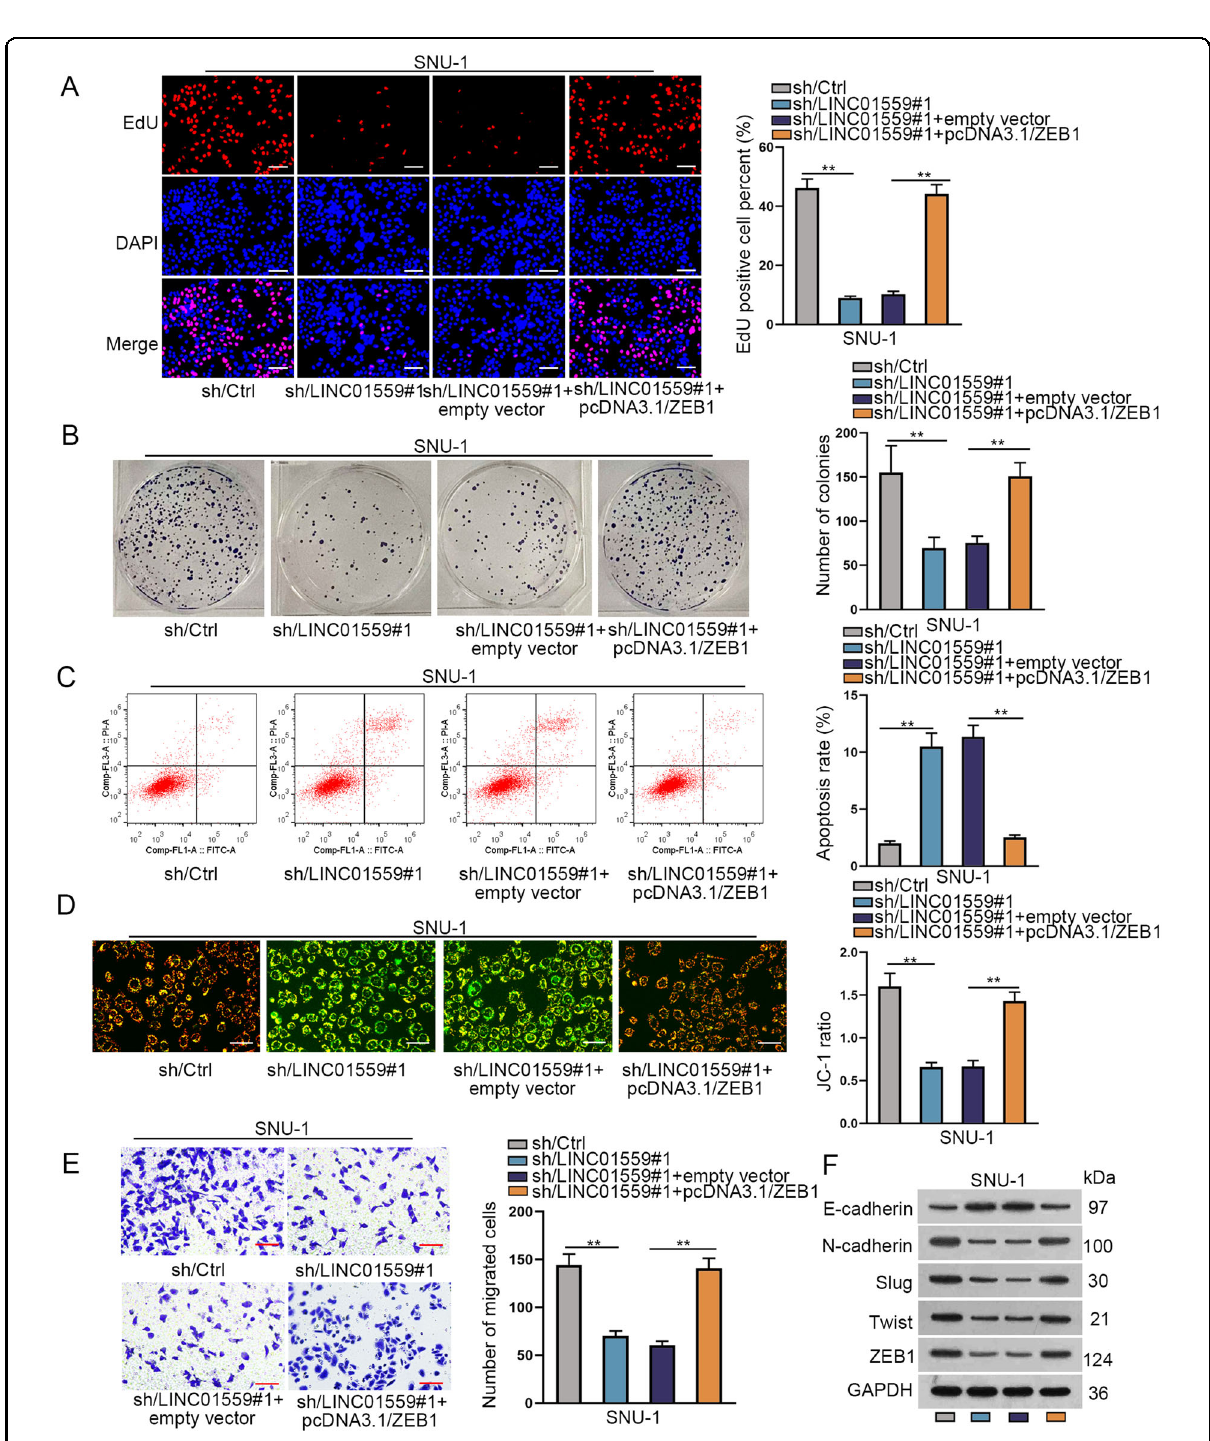
Fig. 6 LINC01559 promotes cell proliferation, migration and EMT process by targeting ZEB1. Rescue experiments were conducted in SNU-1 cells transfected with sh/Ctrl, sh/LINC01559#1, sh/LINC01559#1 + empty vector or sh/LINC01559#1 + pcDNA3.1/ZEB1. A , B EdU assay and colony formation assay estimated the proliferation ability of SNU-1 cells in these four groups. C , D Flow cytometry analysis and JC-1 experiment analyzed the apoptotic rate of GC cells in these four groups. E Transwell assay determined the migration ability of GC cells in these four groups. F Western blot experiments examined the expression of E-cadherin, N-cadherin, Slug, Twist and ZEB1 in these four groups. ** P <